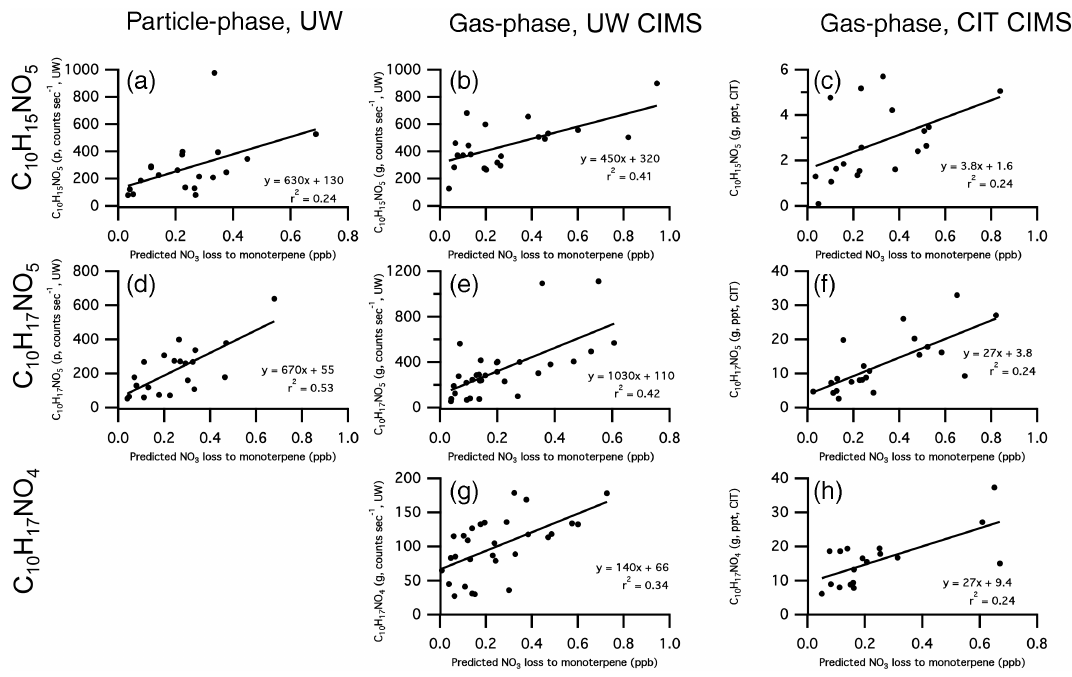
Figure 7. Scatter plots of selected molecules’ concentration buildups against time-integrated monoterpene losses to NO 3 radical, during periods of observed organic nitrate buildup measured by CIMS. Panels (a) and (d) show particle phase C 10 H 15 NO 5 and C 10 H 17 NO 5 measured by the UW FIGAERO; (b) and (e) show gas-phase C 10 H 15 NO 5 and C 10 H 17 NO 5 also measured by UW; (c) and (f) show the same gas-phase species measured by the CIT-CIMS, with calibrated concentrations. Panels (g) and (h) show gas-phase C 10 H 17 NO 4 measured by both CIMS. The gas-phase correlations with calibrated mixing ratios measured by the CIT-CIMS (c, f, h) allow for a rough estimation of the lower limit molar yields via the slopes: C 10 H 15 NO 5 , 0.4%; C 10 H 17 NO 5 , 3%; and C 10 H 17 NO 4 ,